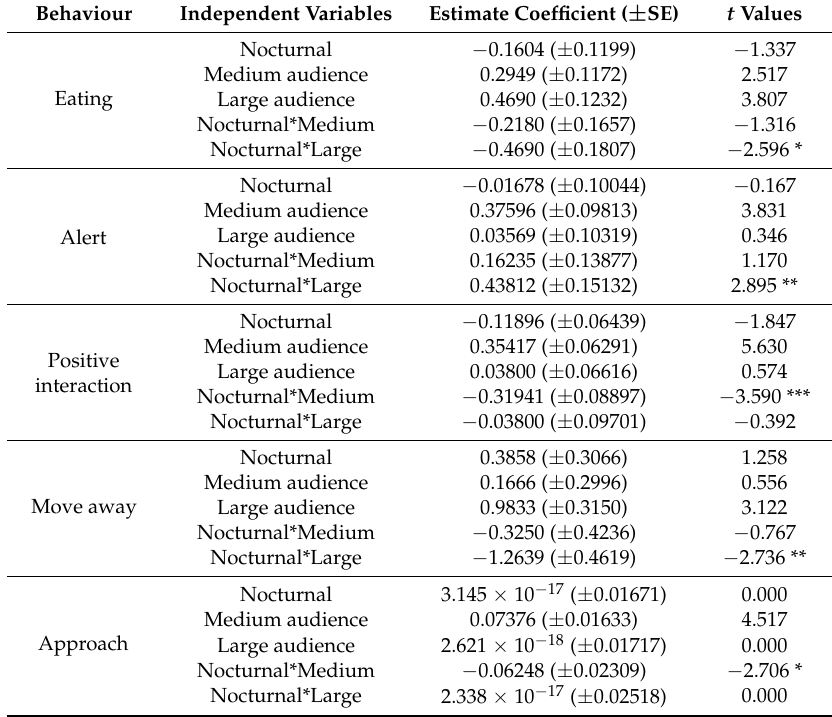
Table 5. Behaviours of zoo mammals significantly affected in the two types of activity cycles (diurnal and nocturnal) and by public category (small, medium and